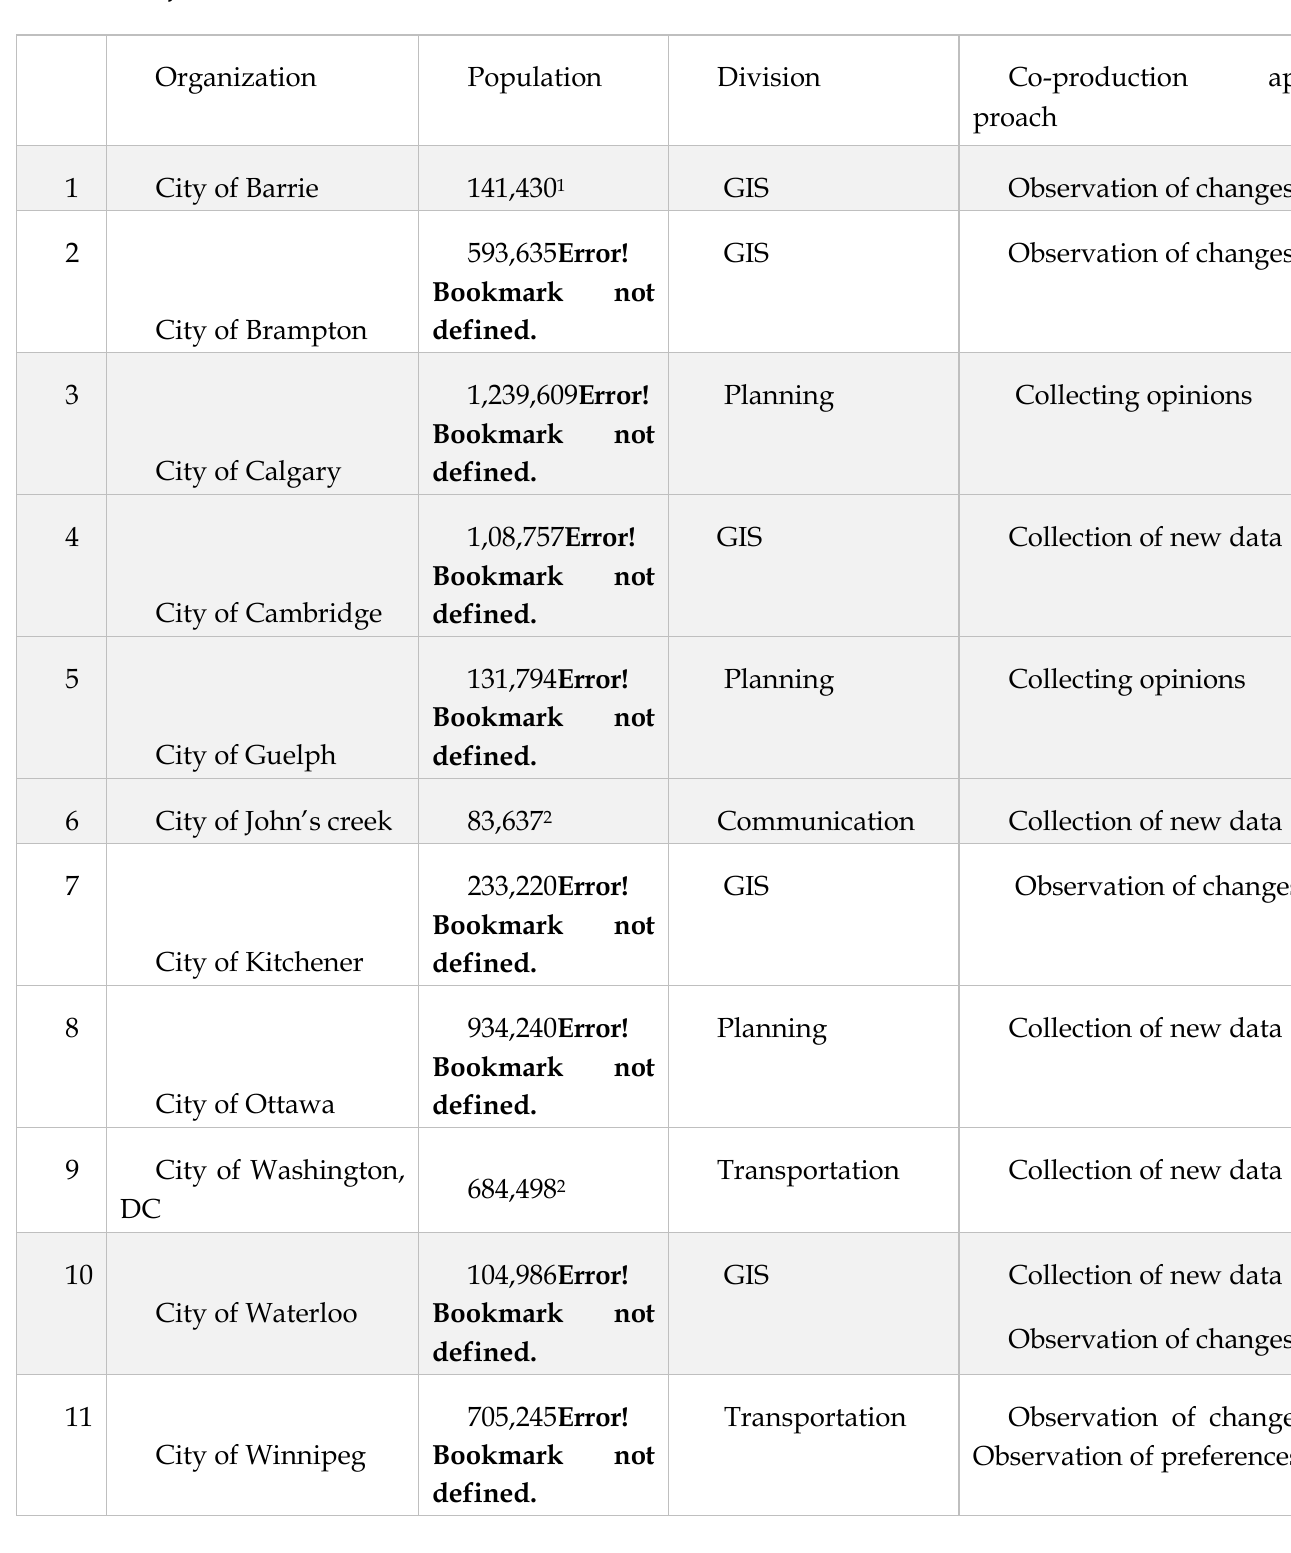
Table 1: List of cases